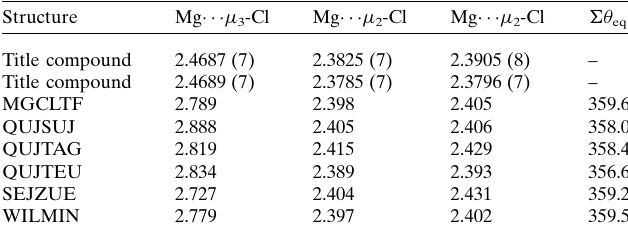
Table 2 Comparison of Mg (cid:3)(cid:3)(cid:3) Cl distances (A˚ ) and sums of equatorial angles (cid:2) (cid:5) eq ( (cid:5) ) of the five-coordinate Mg 2+ ions in the literature phases. There are two rows for the title compound because it does not show any symmetry, whereas all structures retrieved from the database are located at a center of inversion. Mg (cid:3)(cid:3)(cid:3) (cid:2) 2 -Cl: bond lengths are between the five-coordinate Mg 2+ ions and the (cid:2) 2 -Cl (cid:2) ions. Mg (cid:3)(cid:3)(cid:3) (cid:2) 3 -Cl: bond lengths are between the five-